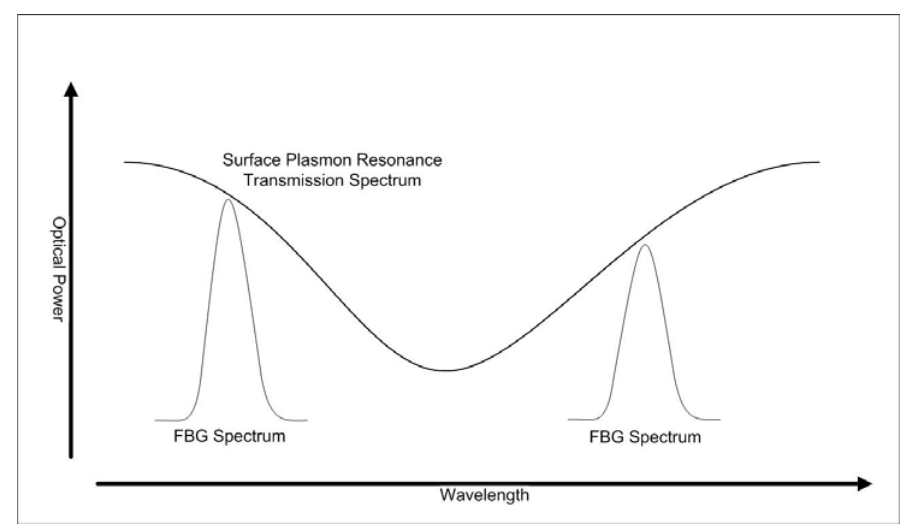
Figure 11. Schematic view of the interrogation system based on